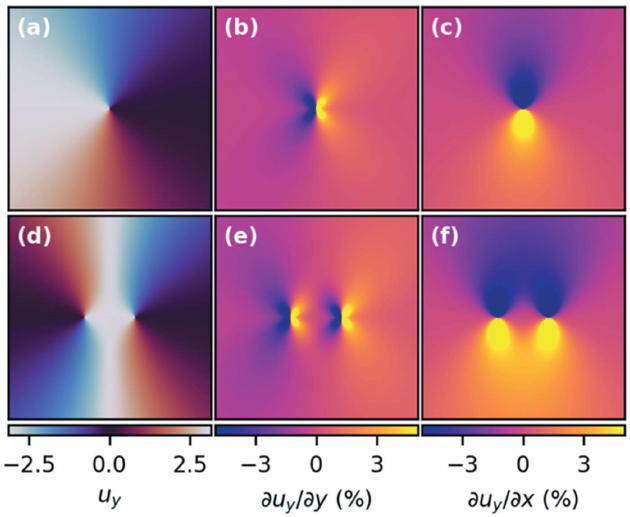
Figure 2 Displacement and its gradient in the presence of crystal defects. ( a ) The displacement field around an edge dislocation with the Burgers vector oriented vertically and the extra half plane inserted from the left. ( b ) The normal strain @ u y / @ y and ( c ) the displacement gradient perpendicular to Q , @ u y / @ x . ( d – f ) The displacement field and gradients for a pair of